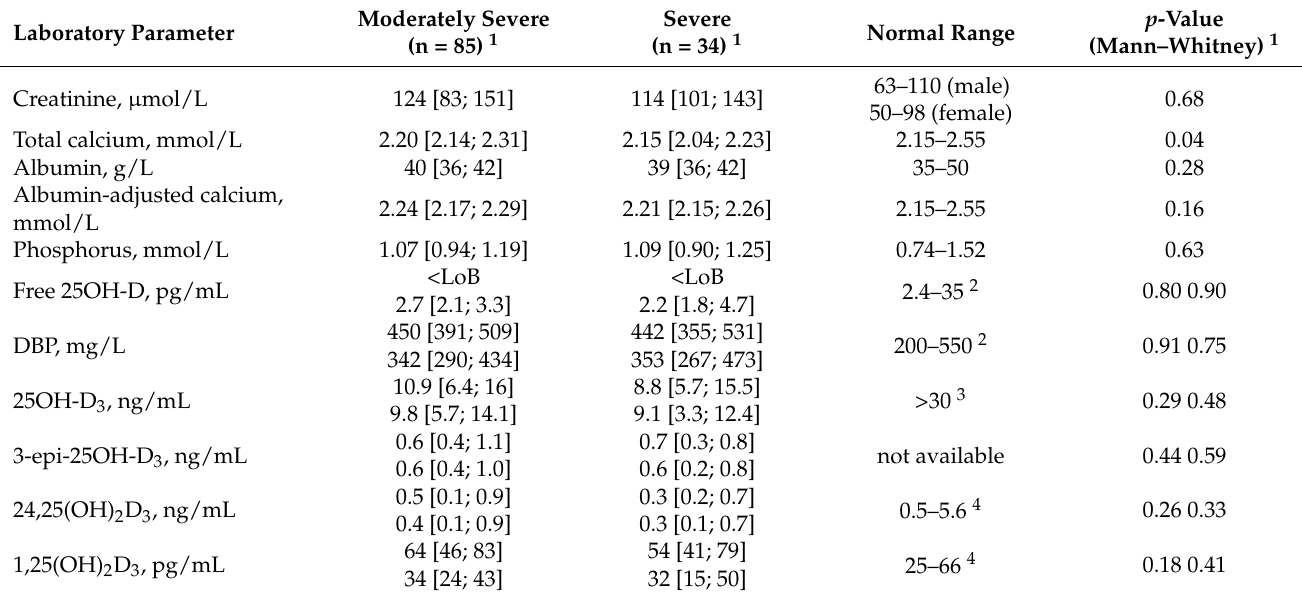
Table 5. Comparison of subgroups of COVID-19 patients depending on the severity of the